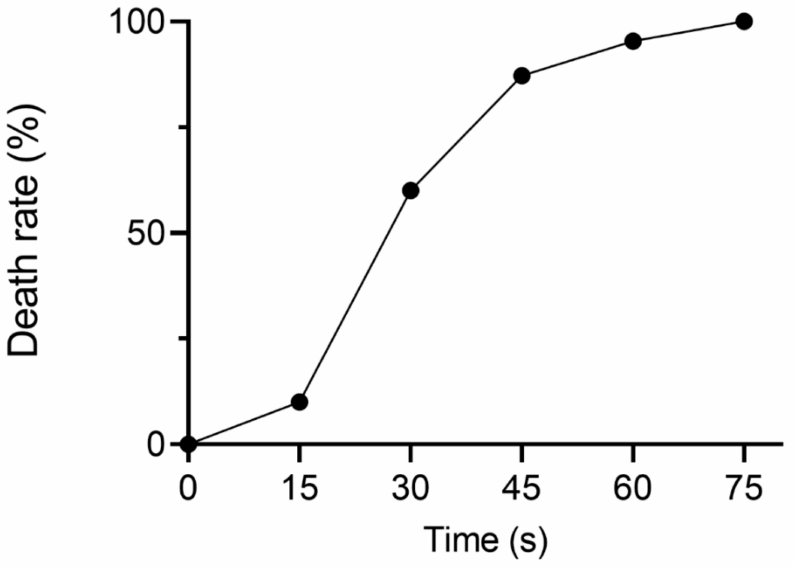
Figure 1. The death rate of YJ-002 at different times of ARTP